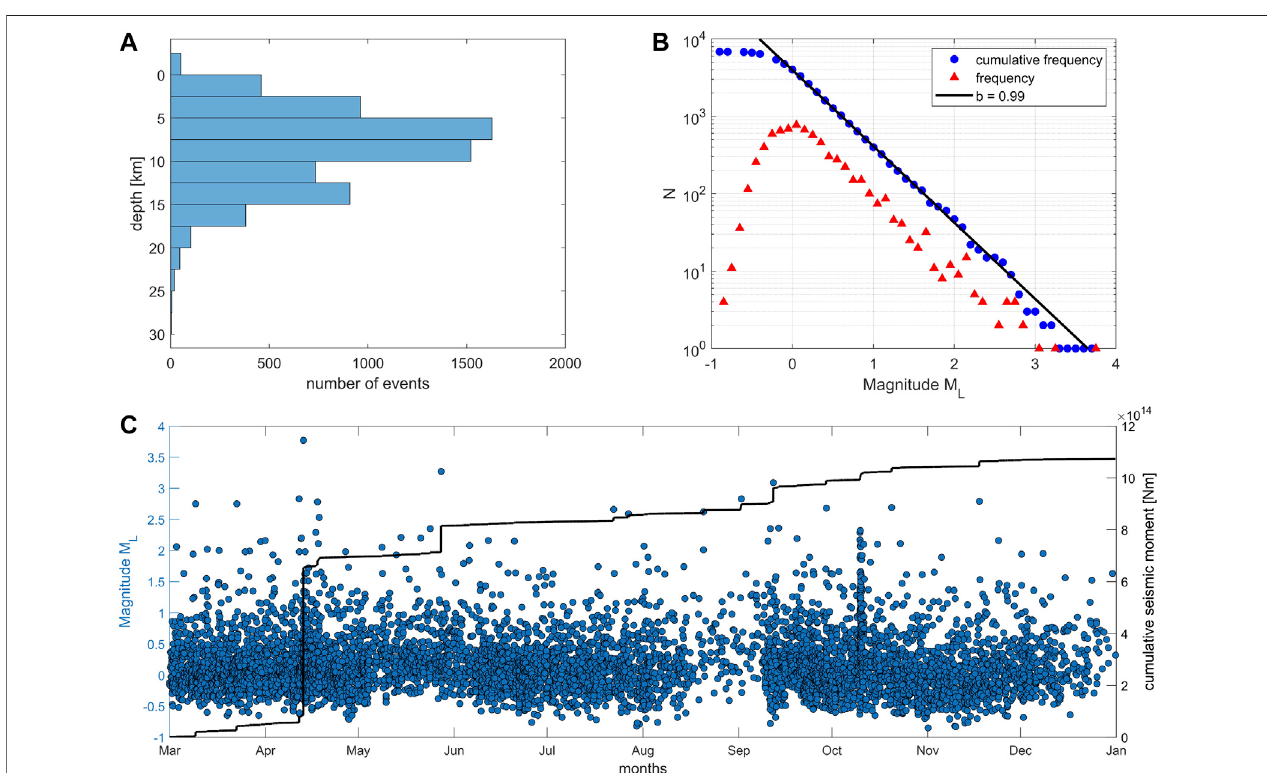
FIGURE 4 | (A) Depth distribution of earthquakes. (B) Cumulative magnitude-frequency and magnitude-frequency distribution. The b-value was calculated after determiningM C usingtheadjustedmaximumcurvaturemethodofWoessnerandWiemer(2005). (C) Magnitudedistributionperdayoverthereported10monthsofdata overlain by the cumulative seismic moment